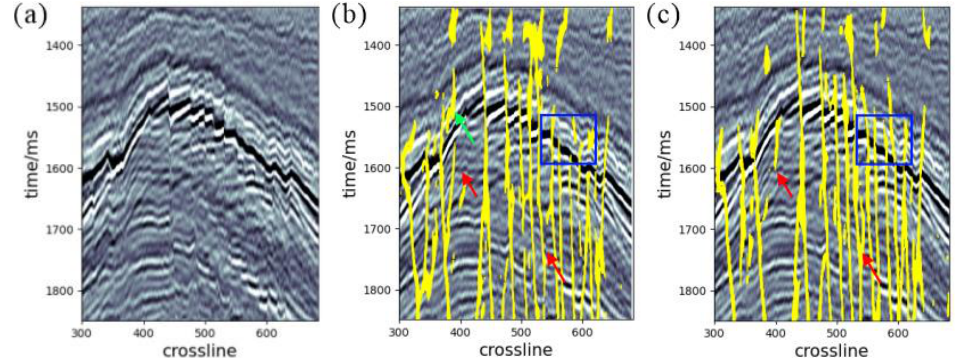
Figure 13. Inline200 profile fault prediction results. ( a ) Seismic profile of Inline200; ( b ) prediction results of Unlet model; ( c ) prediction results of SE-UNet model.